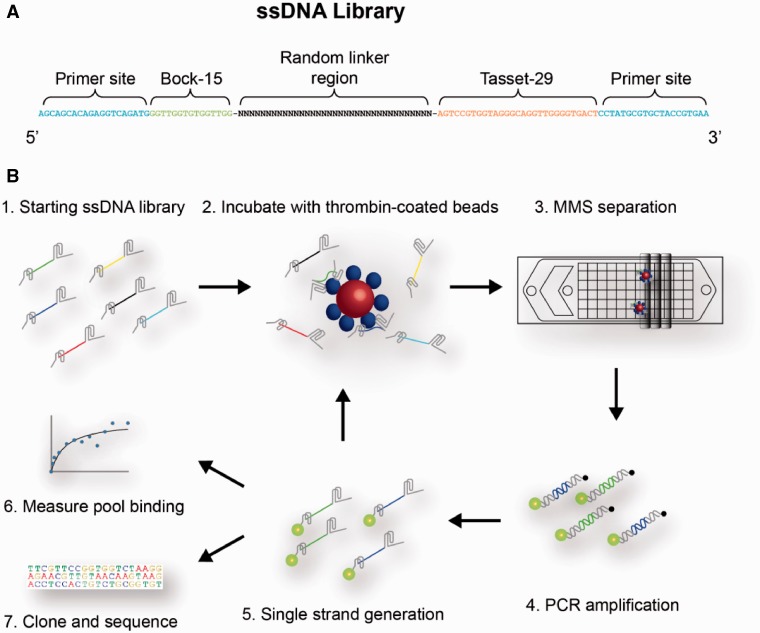
Overview of the bivalent aptamer linker selection process. (A). Each molecule in the ssDNA library consists of two thrombin aptamers, Bock-15 and Tasset-29, joined by a 35-nt randomized linker region and flanked by two primer sites for PCR amplification. (B) The major steps of the microfluidic selection process are shown. Bivalent aptamers are captured by binding to thrombin-coated magnetic beads, and then washed within the MMS device to eliminate weakly and nonspecifically bound ssDNA. The resulting pool is then PCR amplified in a manner that enables rapid subsequent preparation of single-stranded molecules, which can then be subjected to further rounds of selection or directly characterized based on sequence and binding affinity.